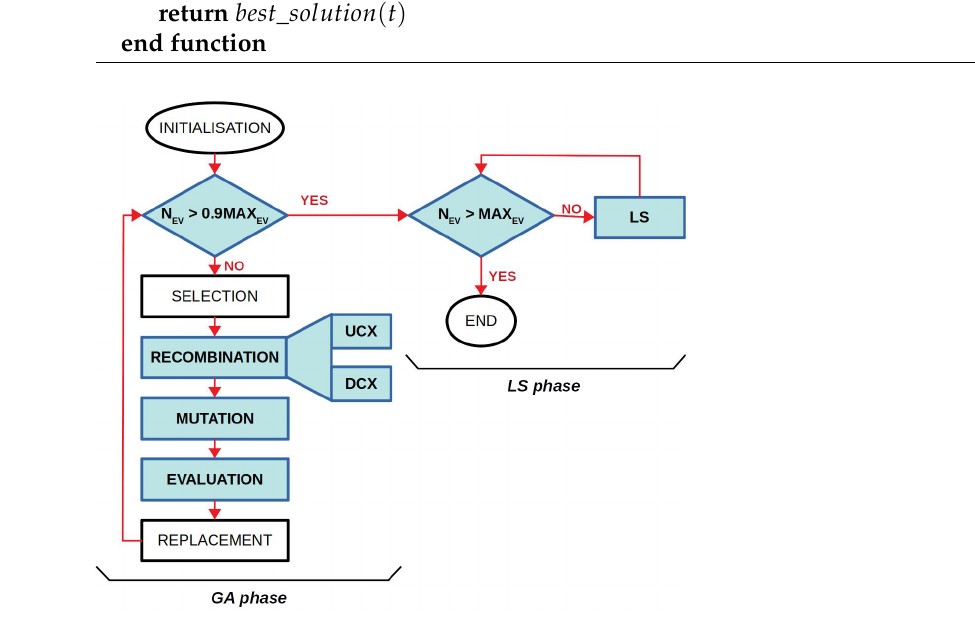
Figure 3. Differences between a canonical GA and our proposed EA shown in coloured